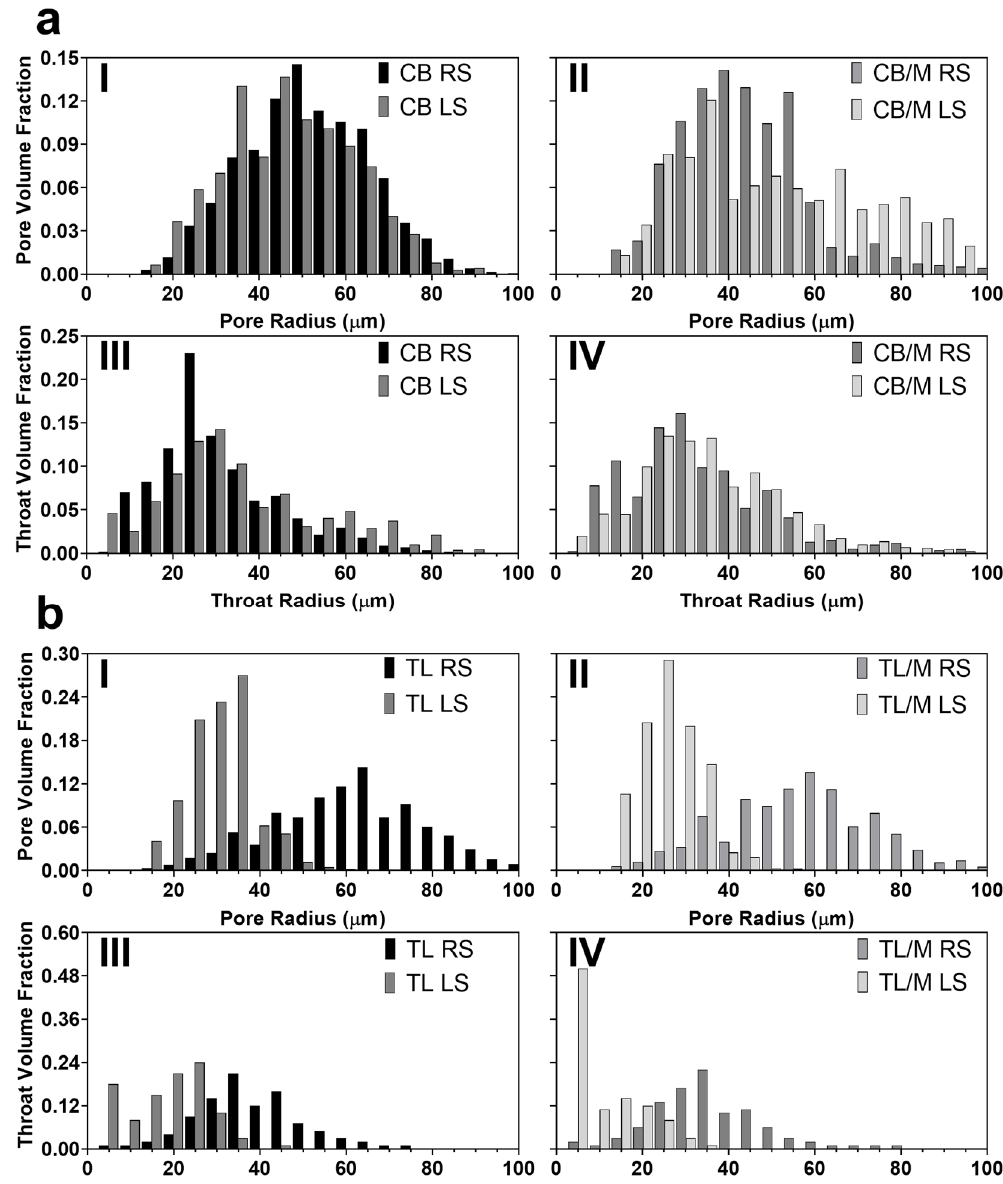
Figure 6. Volume weighted pore (R 43,p ) and throat (R 43,t ) radius distributions for random and laminar sheared samples: ( a ) cocoa butter and ( b ) trilaurin in the presence ( II , IV ) and absence ( I,III ) of monostearate. Bins used for each radius distribution include values within a 5 μ m range centered at their nearest respective tick marks. Distributions presented were computed by taking an average of replicate distributions to represent the average distribution observed.